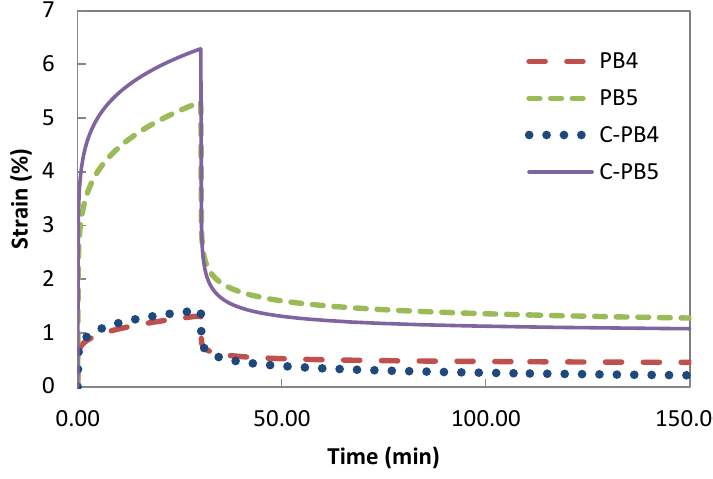
Figure 4. MWCNT and creep-recovery behaviour.